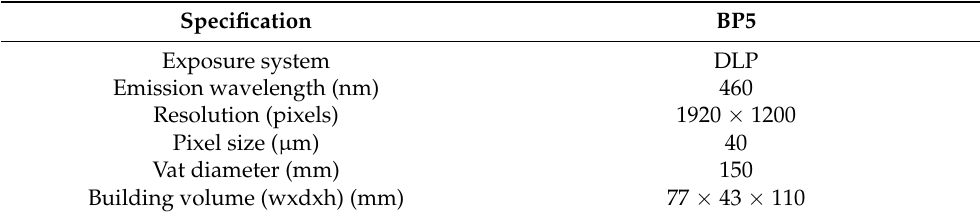
Table 5. Specifications of the LCM prototype .